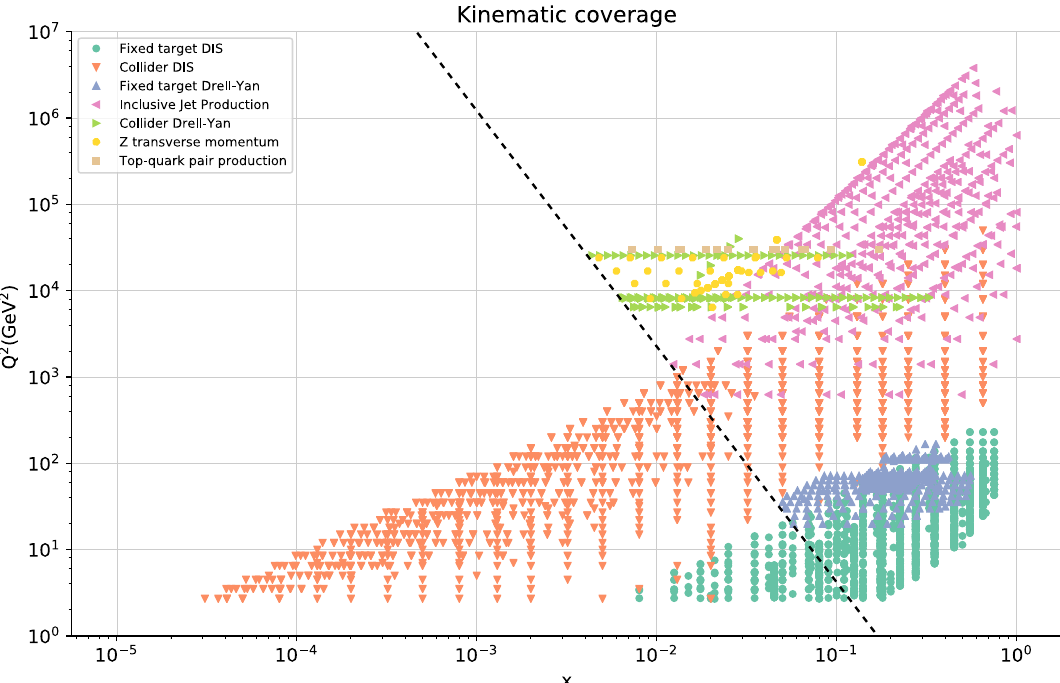
Fig. 7 Thekinematiccoverageinthe ( x , Q 2 ) planeofthedataincluded in the NNPDF3.1sx fit with the default value of the kinematic cut to the hadronic data, H cut = 0 . 6. The diagonal line indicates the value of the